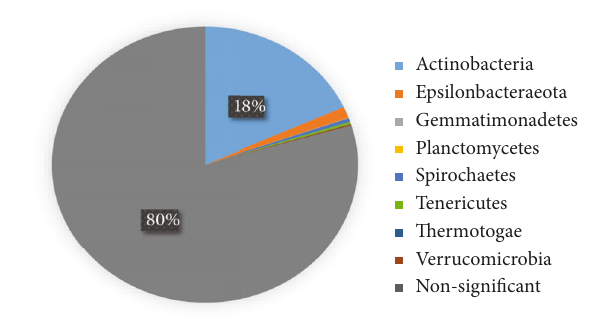
Figure 7: The proportion of 8 signi fi cant di ff erent phyla categories between the 2 groups. Actinobacteria (18.15%), Epsilonbacteraeota (1.32%), Spirochaetes (0.43%), Tenericutes (0.30%), Gemmatimonadetes (0.02%), Planctomycetes (0.04%), Thermotogae (0.01%), and Verrucomicrobia (0.14%).